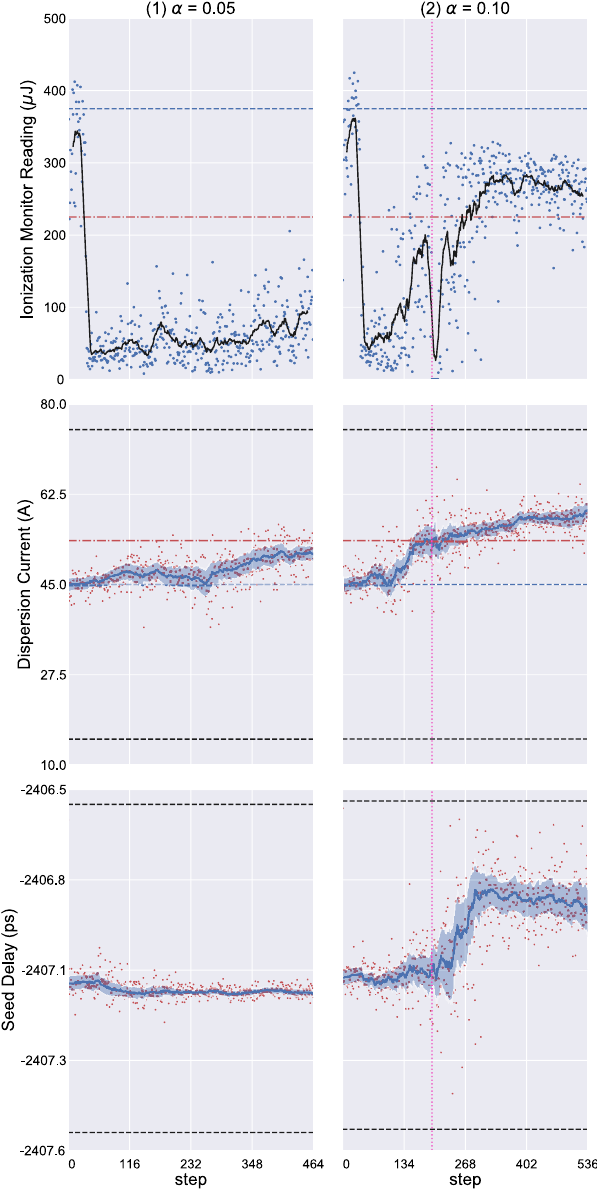
FIG. 11. Optimization of an HGHG free-electron laser using the dispersive strength and seed laser delay. The two columns show two different trials with the learning rate given at the top of each column. The top row shows the FEL energy as measured by an ionization monitor wherein the blue dots are the mean reading after each step and the black line is a rolling 20-point average. The remaining panels show the policy distribution of the different control parameters. The blue dashed lines show the settings found by a human operator, the red dash-dot lines show the settings (if any) predicted by a simplified HGHG model and the black dashed lines show the allowed range of operation of the control parameters. The dotted magenta, vertical lines show the occur- rence of a fault in the accelerator system, whereafter the beam is temporarily